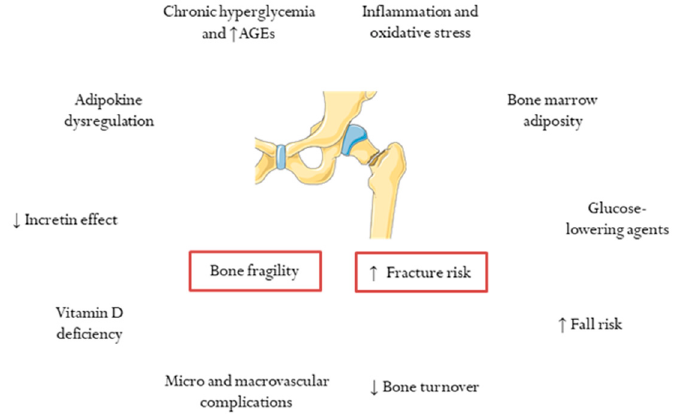
Figure 1. Determinants of bone fragility and increased fracture risk in type 2 diabetes. AGEs, advanced glycation end products.